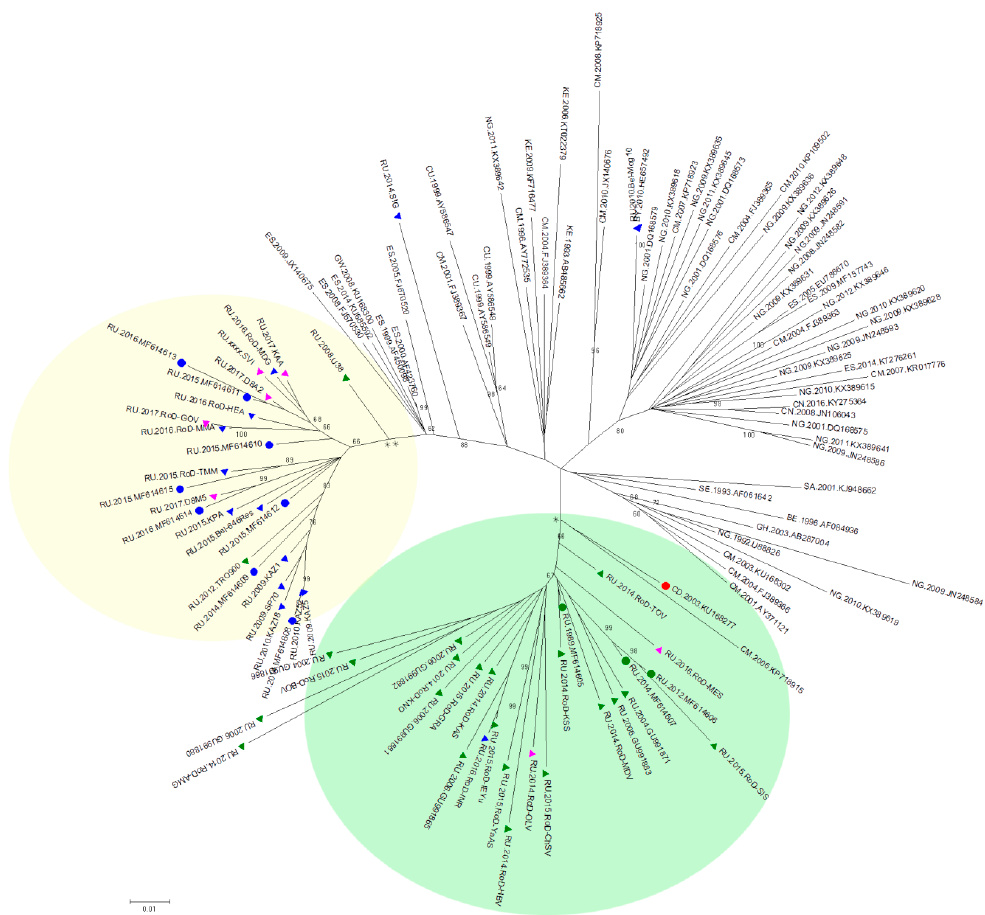
Figure 2. Maximum likelihood (ML) tree (500 bootstrap replicates) of the pol region sequences of subtype G. The red circle indicates the sequence from the Democratic Republic of the Congo. The green circles indicate sequences from patients from the nosocomial outbreak. The green triangles indicate sequences from Russian patients diagnosed between 1988 and 2006. The blue circles indicate the near full-length genome sequences of the infected patients from Russia who were diagnosed after 2010. The blue triangles indicate sequences from Russian patients diagnosed between 2007 and 2015. The purple triangles indicate sequences from Russian patients with unknown diagnosis dates. The sequence from the Democratic Republic of the Congo and samples from patients living in the territory covered by the outbreak are highlighted in the green oval. Samples from patients with a first positive immune blot test predominantly after 2007 are highlighted in the yellow oval. The name of each sequence consists of the country code, sampling year and accession number (Los Alamos) or sample name (Russian database) separated by dots. The symbol XXXX marks the samples for which the date of sampling is unknown. Only bootstrap values of more than 60% are shown. *-38% bootstrap support, **-41% bootstrap support.